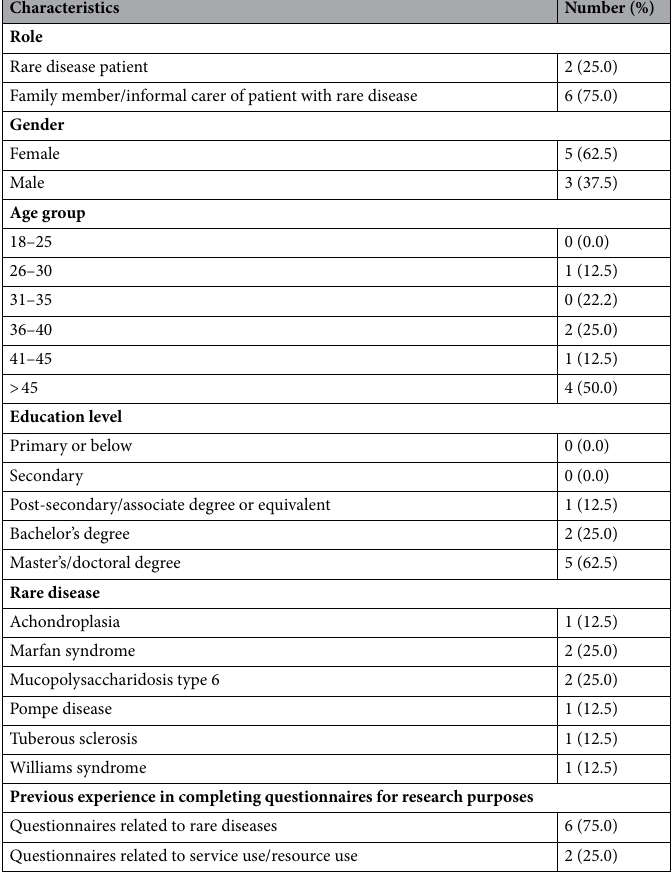
Table 1. Characteristics of the eight rare disease patients or carers in the first focus group